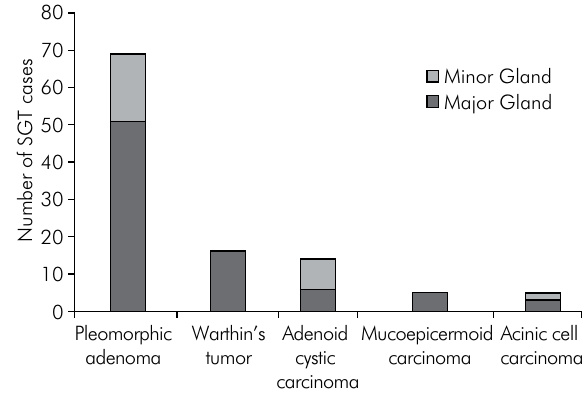
Figure. Distribution of 109 salivary gland tumors according to occurrence in major or minor salivary